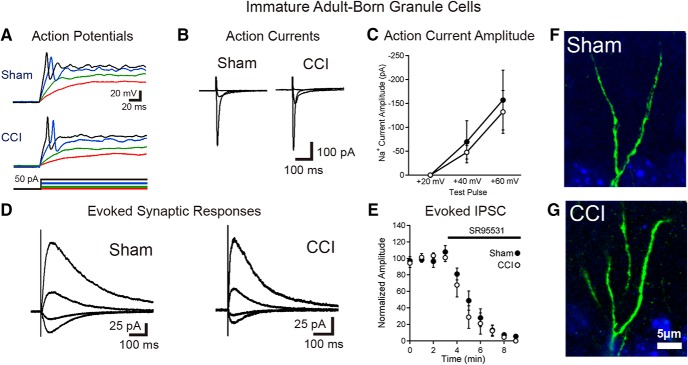
Immature granule cells born after TBI are excitable and integrated into the hippocampal circuitry. A, Current-clamp recordings from GFP-positive immature granule cells born after sham or CCI surgery demonstrate that cells born after TBI fire action potentials during depolarizing current injection. Respective voltage traces during current injections of +5 pA (red), +10 pA (green), +30 pA (blue), and +40 pA (black) for both sham and CCI-treated animals are shown. Summary data are given in the text. B, C, Single-cell, voltage-clamp recordings demonstrate that immature granule cells have similar voltage-dependent action currents. B, Averaged action currents from example cells during steps of +20, +40, and +60 mV from a holding potential of −70 mV. C, Summary data of the amplitude of the action current response in response to the various steps between groups (sham = 7 cells; CCI = 7 cells; p = 0.6554 with a +40 mV step; p = 0.7555 with a +60 mV step). D, Synaptic currents elicited in immature adult-born neurons in response to stimulation at the IML/MML border, while voltage clamping the cells to −70, −40, 0, and +40 mV. E, Summary data of response amplitudes of evoked currents (recorded while clamping cells at +40 mV), demonstrating almost complete block of the evoked synaptic response by the GABAAR antagonist SR95531 (10 μm; n = 5 cells per group). F, G, High-power imaging of dendrites from newborn neurons in sham and CCI-treated mice show no evidence of dendritic spines on immature GFP+ cells in either condition.